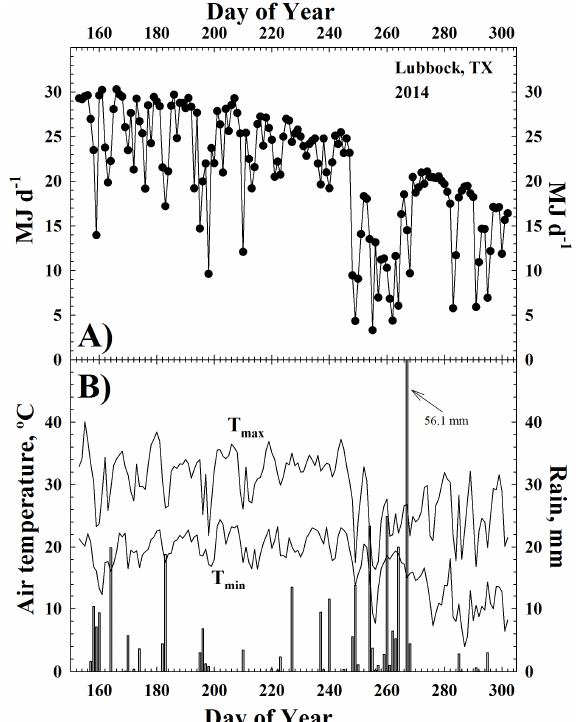
Figure 1. ( A ). Total solar irradiance vs. day of year; ( B ). Maximum (Tmax) and minimum (Tmin) air temperature vs. day of year. Histograms on the x-axis indicate rainfall events and amounts on the right side y -axis.